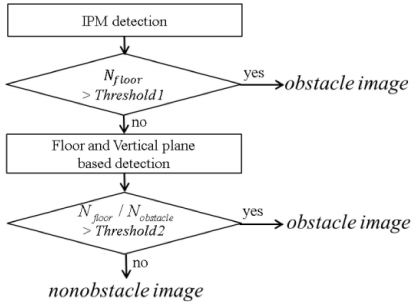
Figure 10. Decision rule for distinguishing between obstacle and nonobstacle